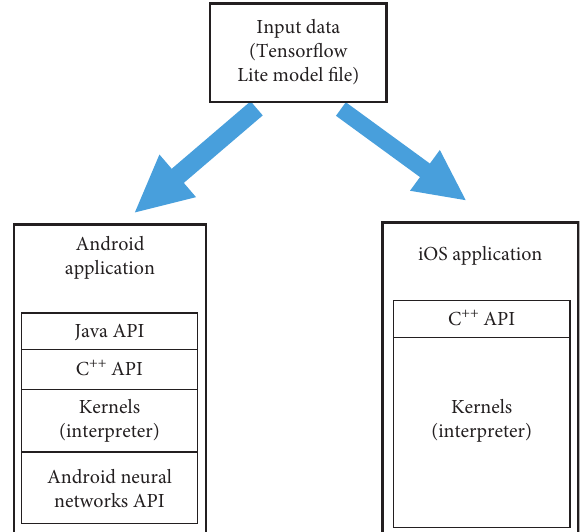
Figure 13: Applications on mobile.